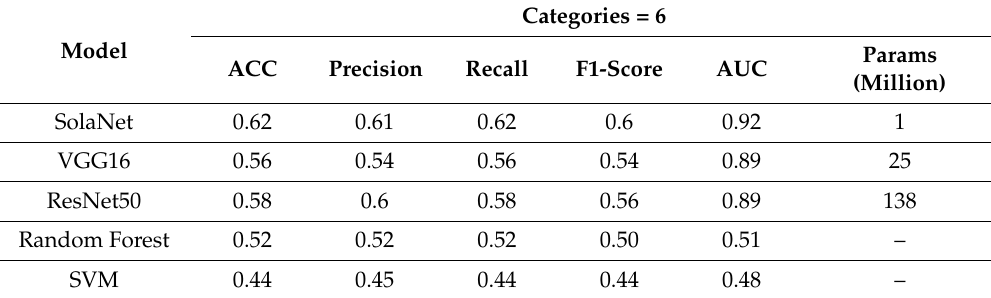
Table 3. Performance of SolaNet and other popular models.